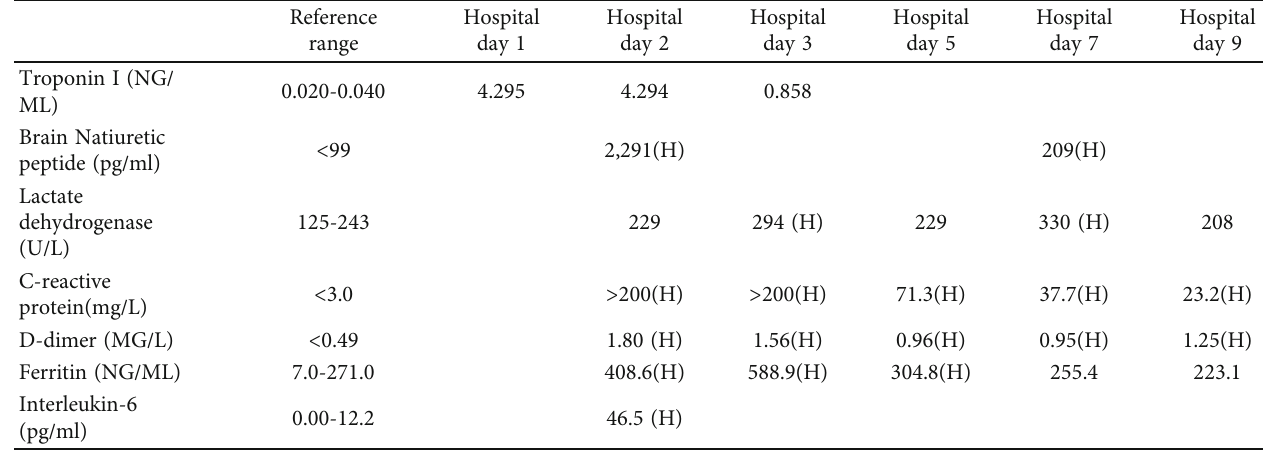
Table 1: Demonstrating all lab values during her Hospital course.